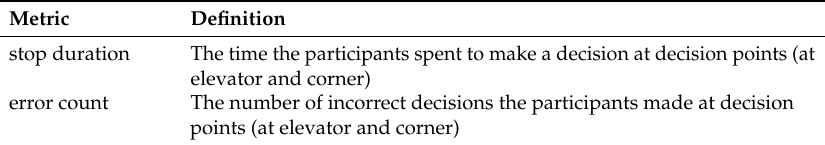
Table 7. Definitions of stop duration and error in Task 3.